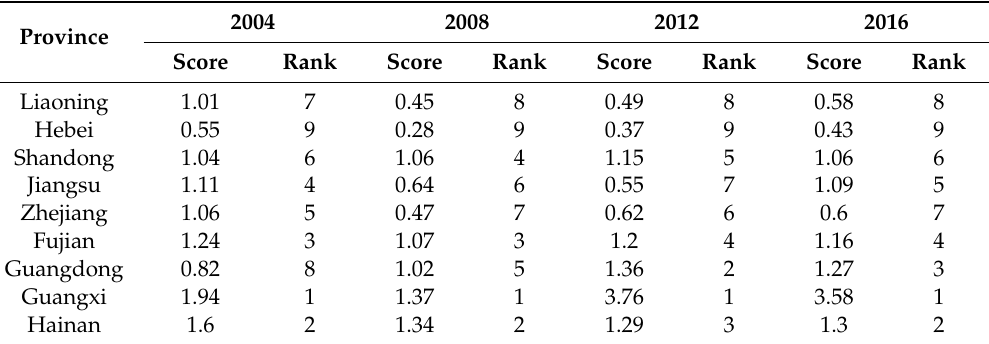
Table 4. Mariculture e ffi ciency in the coastal areas of China,